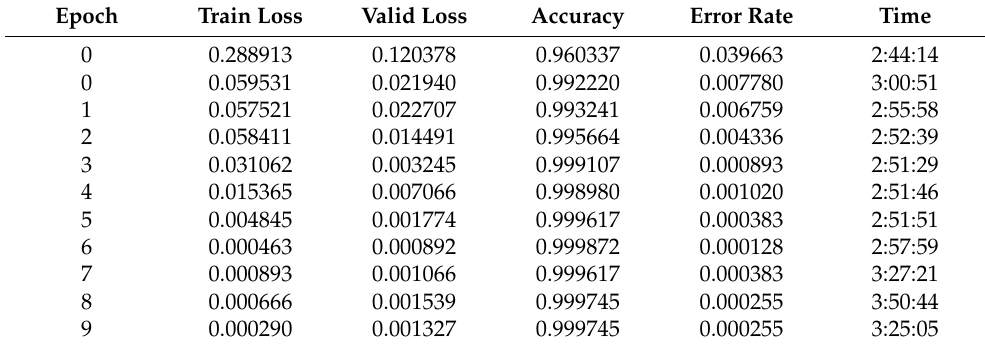
Table 11. Results of the DenseNet 169.